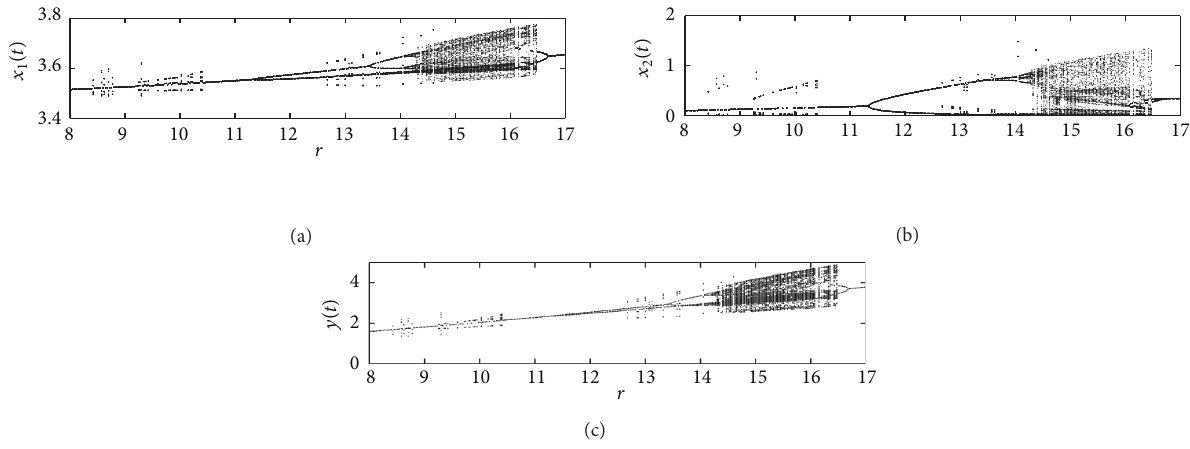
Figure 6: Bifurcation diagrams of system (1) with 𝜔 = 0.2, 𝛽 = 4, 𝜇 = 4, 𝑘 = 0.2, 𝑝 0 = 0.1, 𝑝 = 0.6, 𝑑 1 = 0.1, 𝑑 2 = 0.2, 𝑑 3 = 0.15, 𝜏 = 0.05, 𝑎 = 5, 𝑏 = 7 , and 𝑇 = 4 , where the birth rate 𝑟 varies from 8 to